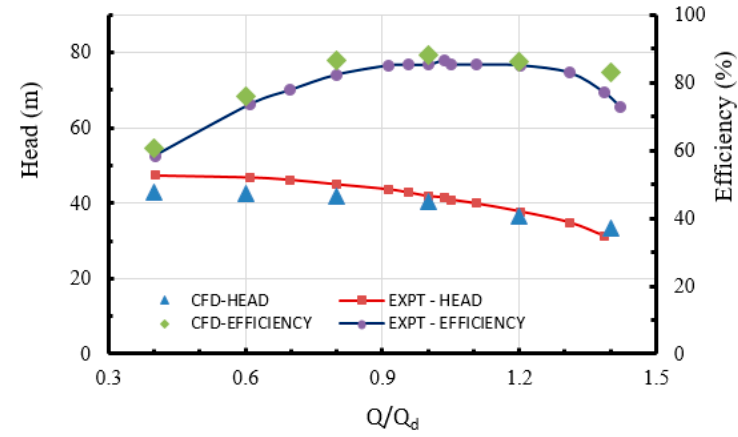
Figure 10. Hydraulic performance comparison of test and numerical results.